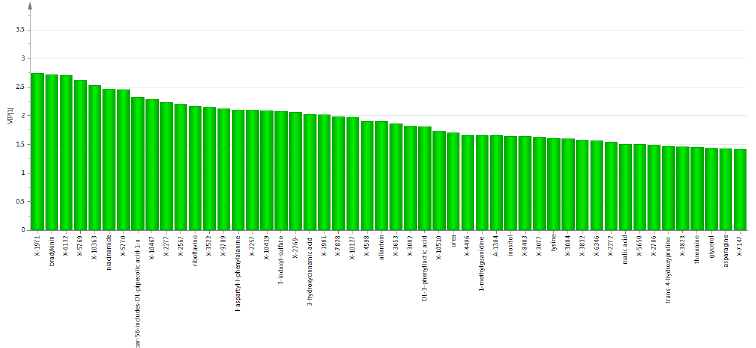
Fig 7. Plasma metabolites key to group separation predicted by PLS-DA assessed using variable influence on projections (VIPs). The most significant known hits for plasma VIPs included: bradykinin, niacinamide, riobflavine, 3-indoxyl-sulfate, and 3-hydroxycinnamic acid. Levels of plasma bradykinin increased more than 25-fold following high dose irradiation. Based on its vasodilator effects, bradykinin may help increase permeability in vasculature damaged by radiation. As in the previous figures, VIP values greater than 1 delineated metabolites most important for cluster